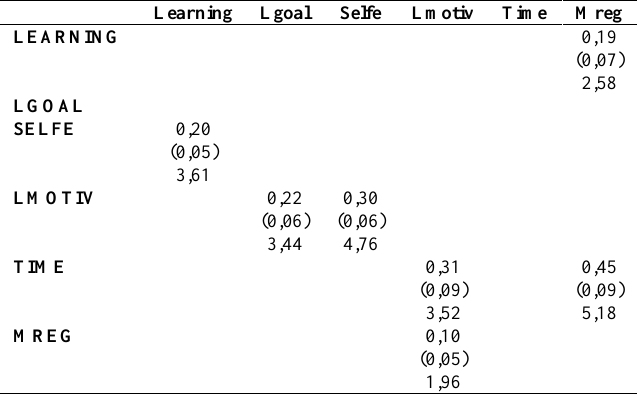
Table 6: Unstandardised beta